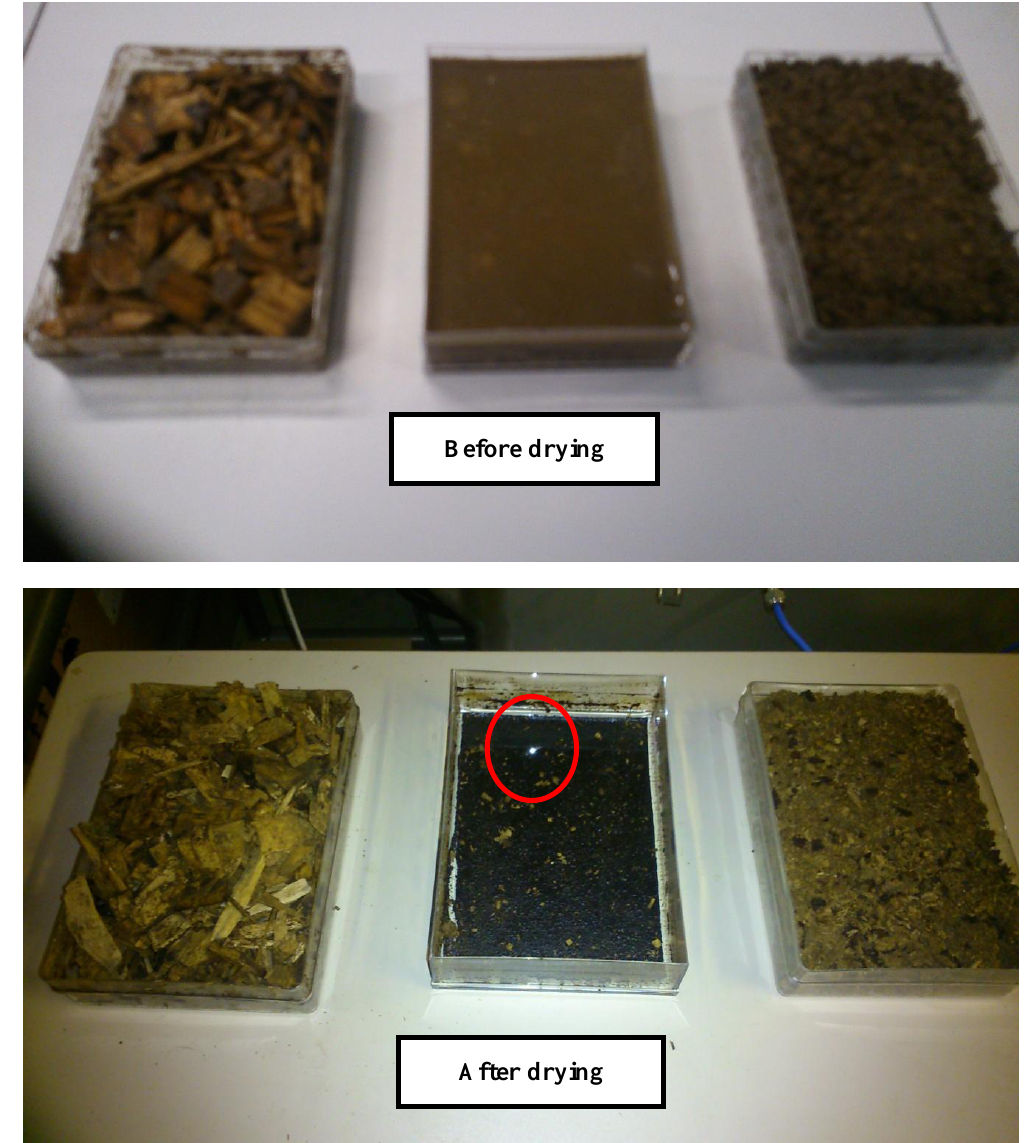
Figure 5. IWC, OMWW, and IS before and after drying .